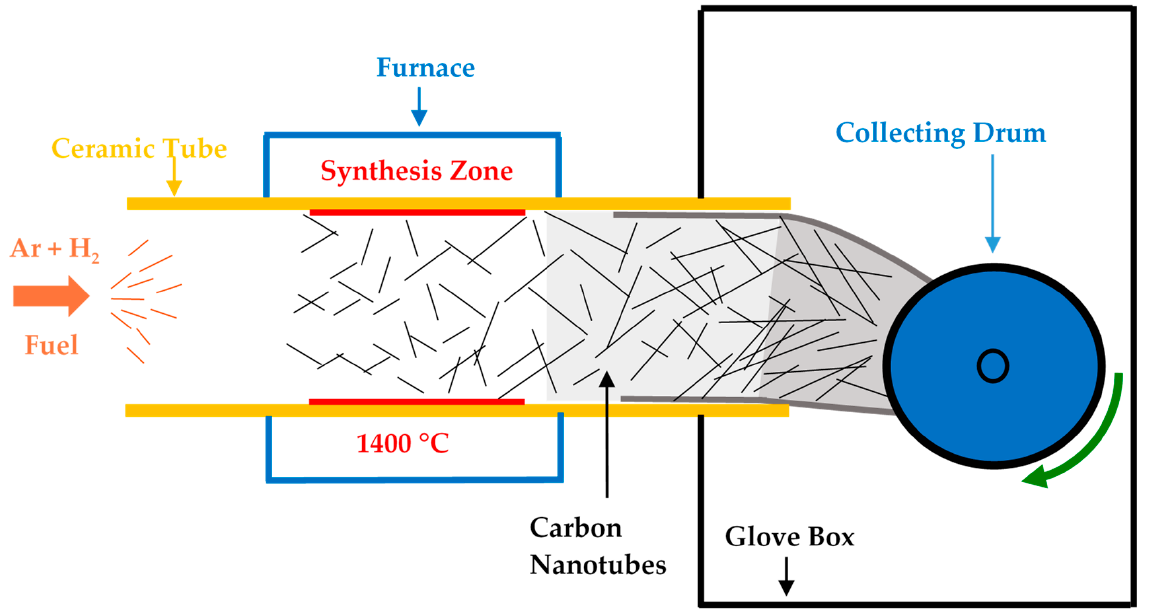
Figure 2. Schematic representation of CNT synthesis by the floating catalyst gas phase CVD method. Table 1. Metallocene mass dissolved in 100 mL of the